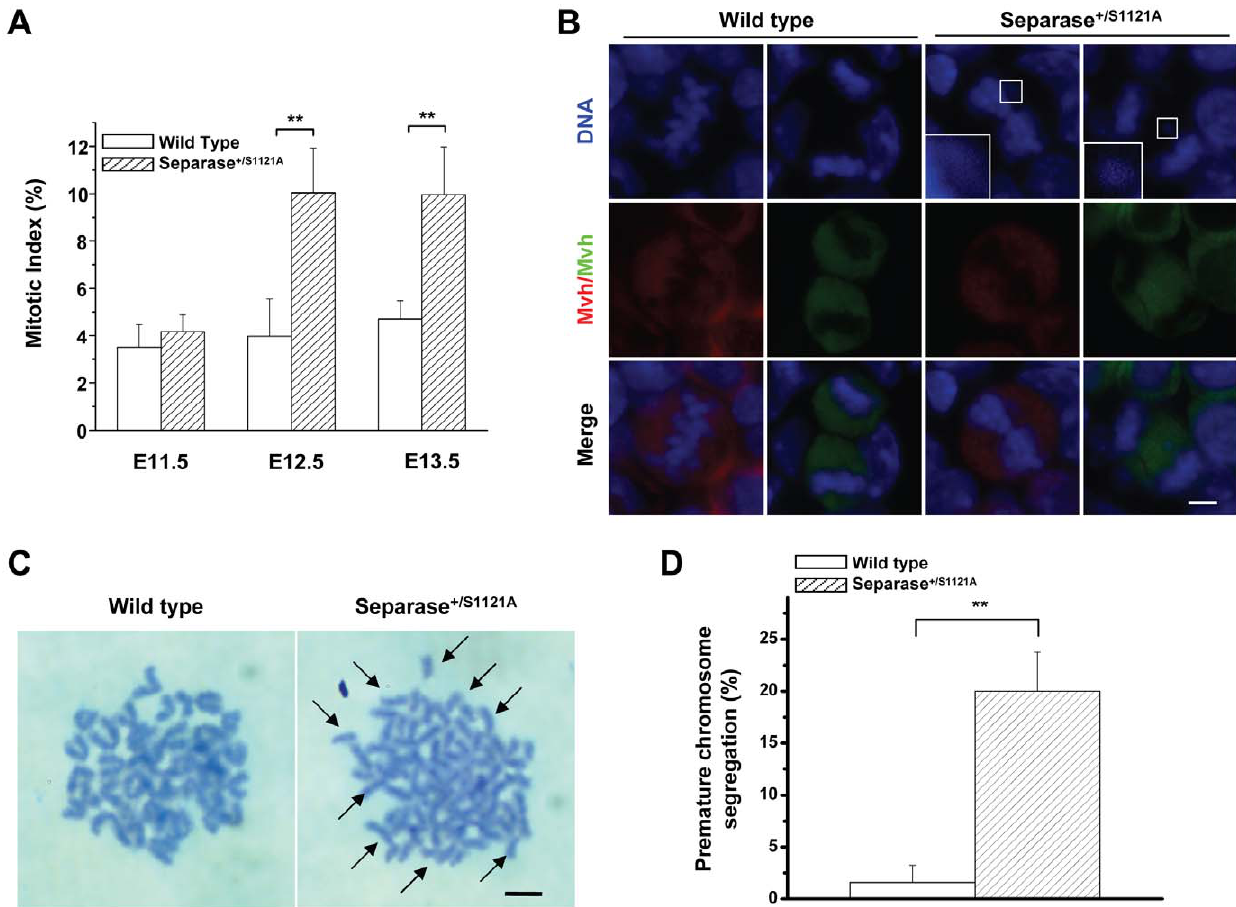
Figure 3. Abnormal mitotic chromosome segregation in PGCs of female Meox-2-cre/Separase S1121A mutant mice. A. The graph shows the calculated mitotic indices of the female PGCs from wild-type and Separase S1121A gonads of various ages as indicated (n=3) (** p , 0.001, T test). B. Aberrant mitotic configurations of female PGCs at 13.0 dpc detected by immuno-staining with Mvh (green/red) and DNA (blue). Inset: higher magnification of DAPI-stained misaligned chromosome and lagging chromosome. Bar=0.5 m m. C. Chromosome spreads of cultured female PGCs at 13.0 dpc after 6 h nocodazole treatment. Arrows indicated the prematurely separated sister chromatids. Bar=1.0 m m. D. Quantitative analysis of premature chromosome segregation from chromosome spreads of cultured female PGCs at 13.0 dpc after 6 h nocodazole treatment (n=4) (** p , 0.001, T test).